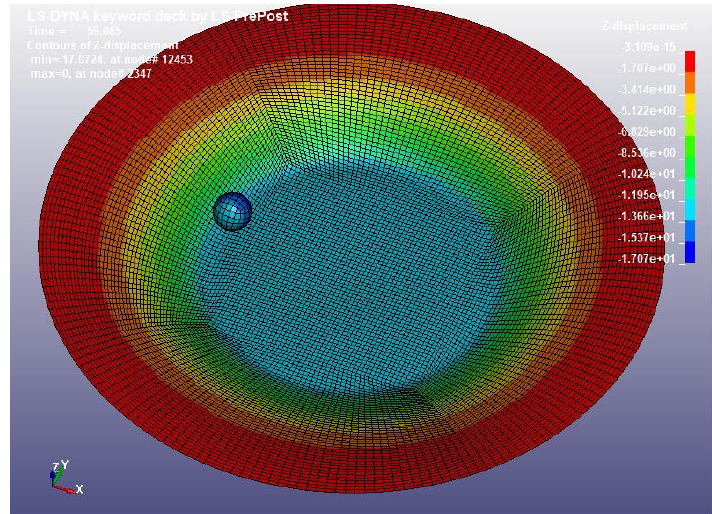
Figure 12. Simulated FE model with Z-direction displacement contour plot.